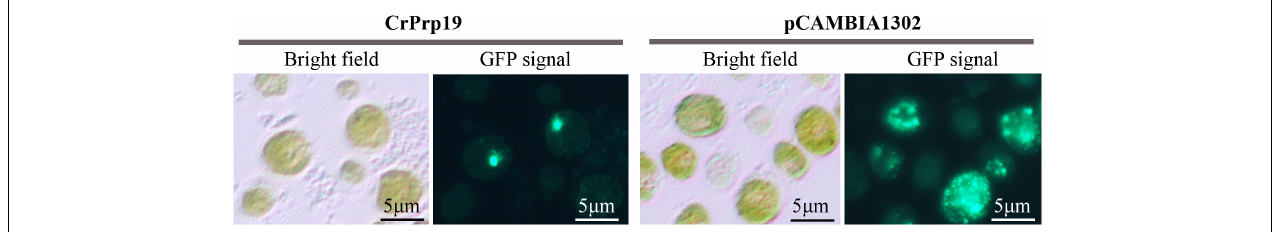
FIGURE 7 | Nuclear localization of the CrPrp19 protein. C. reinhardtii CC124 cells were transformed via Agrobacterium -mediated genetic transformation method with a fusion gene construct including a truncated CrPrp19 gene fused in frame with a GFP coding gene and driven by the CaMV35S promoter. Cells were fixed and observed by fluorescent microscopy using an excitation wavelength at 488